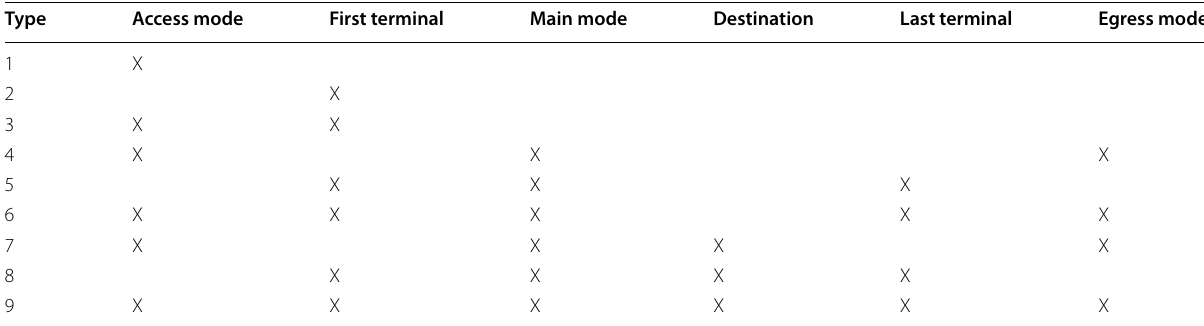
Table 2 Included choice dimensions of the model types in the developed typology for connection trip modelling